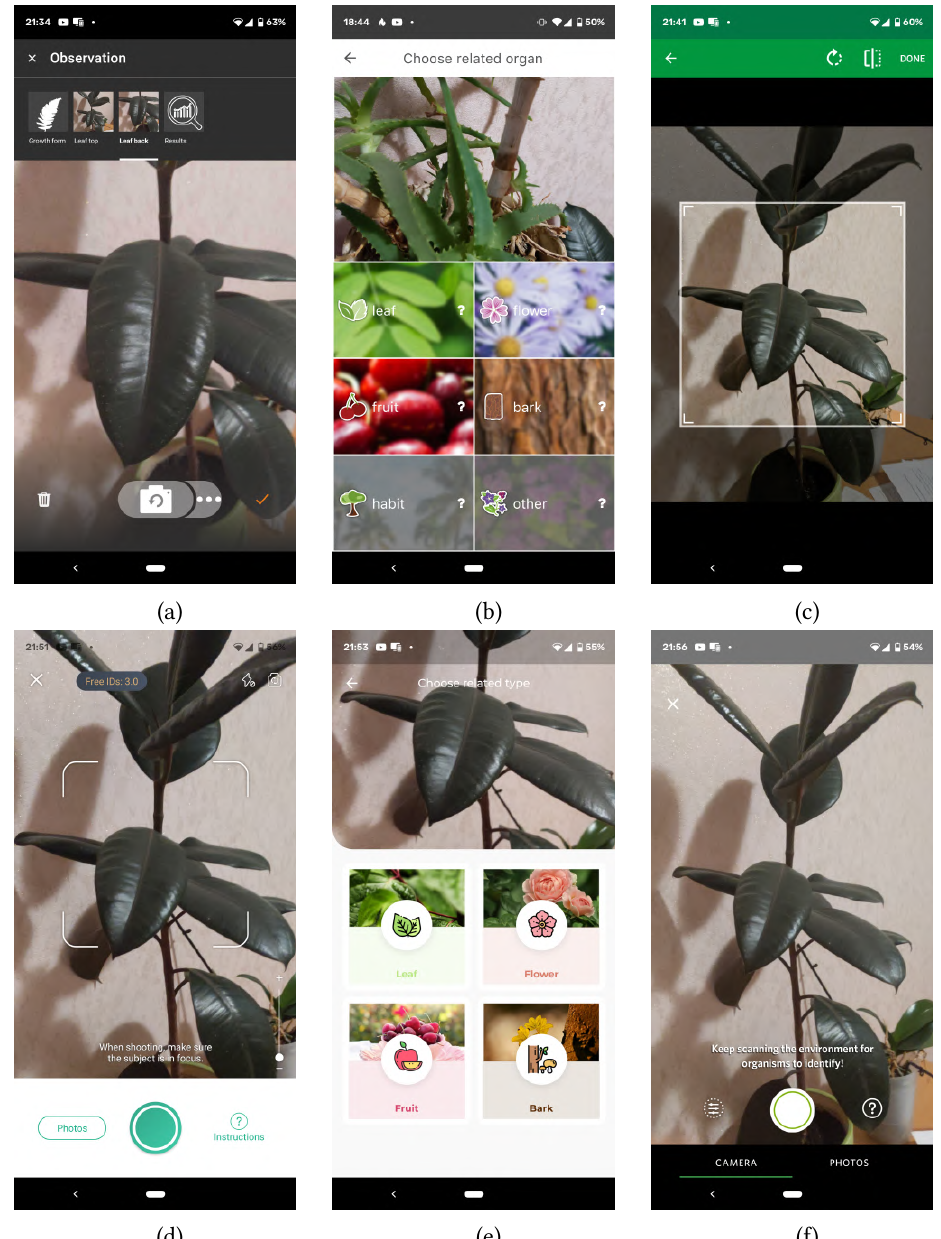
Figure 3: The interface of photo and data input of Flora Incognita (a), PlantNet (b) PlantSnap (c) PictureThis (d) LeafSnap Seek (e)